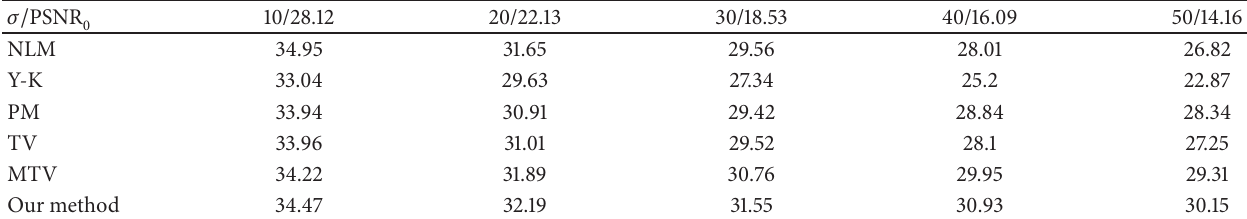
Table 4: PSNR comparison with different methods for the “lena” image.